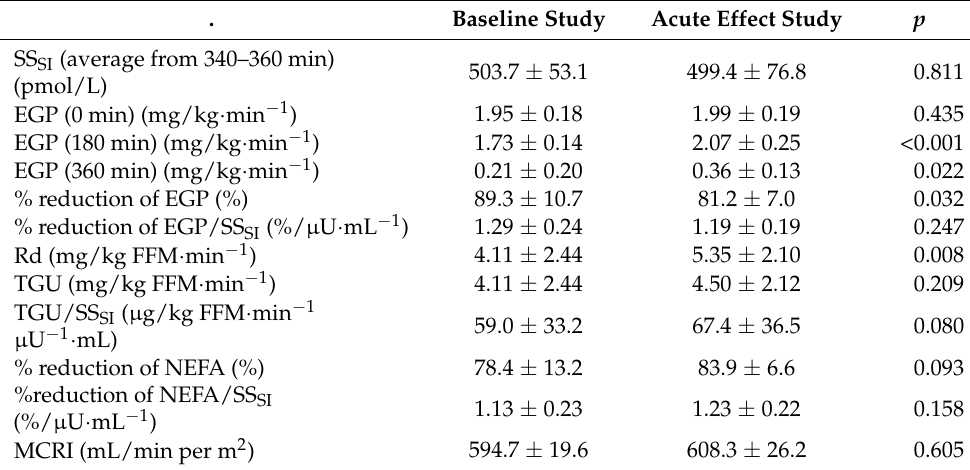
Table 2. Hyperinsulinemic euglycemic clamp data in the baseline and acute effect studies.